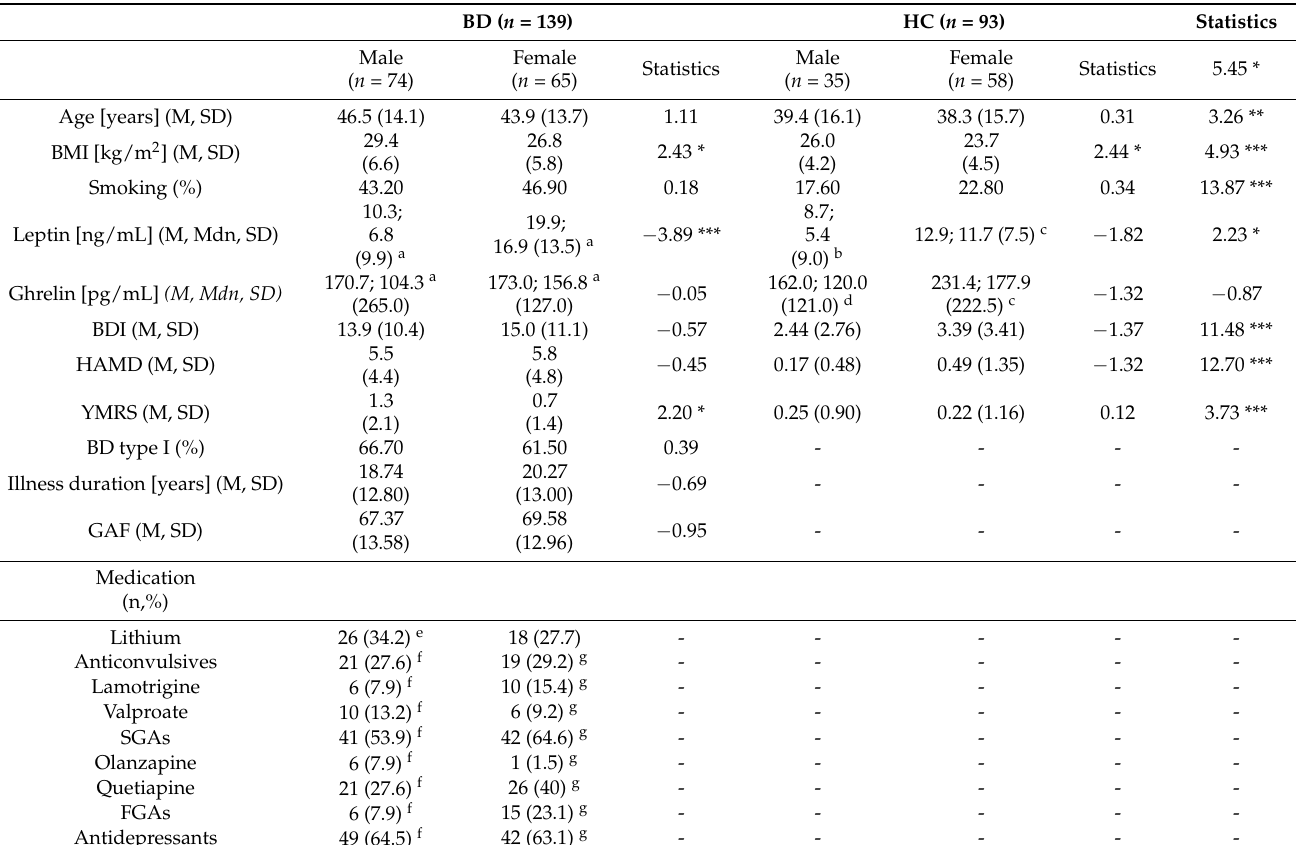
Table 1. Differences in demographic and clinical characteristics between individuals with BD and HC stratified by